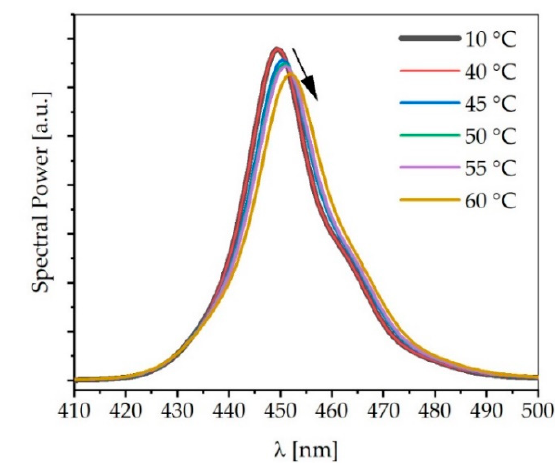
Figure A1. Plot of the LED spectrum as a function of the LED-thermostat temperature.